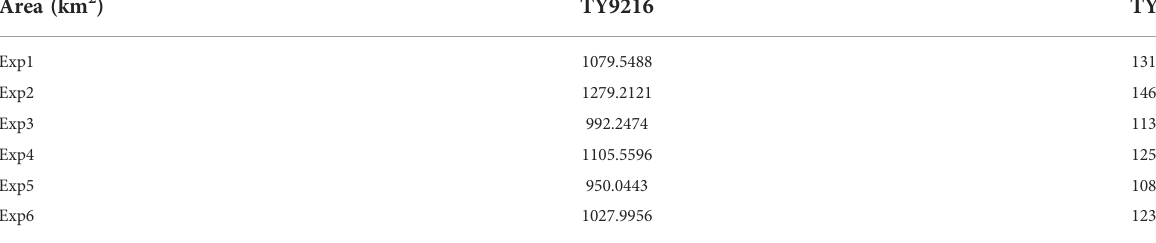
TABLE 3 The total inundation areas (unit: km 2 ) along the LZB during TY9216 and TY1909. Area (km 2